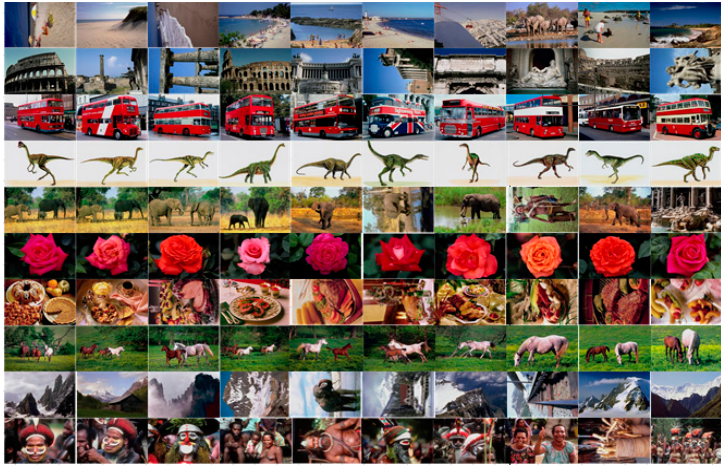
{ } 1,1 21 == λλ . Figure 7. Examples of the top 10 retrieved images for each class in Corel-1k with { λ = 1, λ = 1 } 2 1